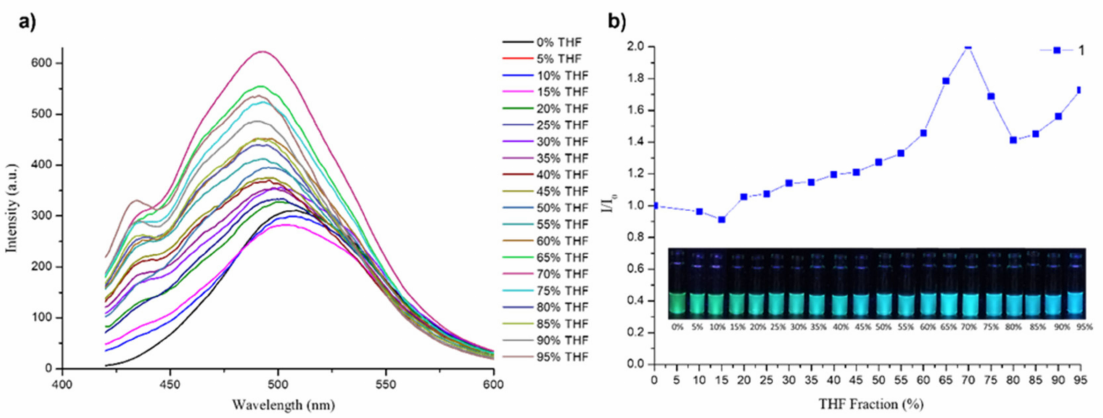
Figure 13. ( a ) Room-temperature emission spectra of 1 in MeOH/THF mixtures of different propor- tions upon excitation at 324 nm. ( b ) Plot showing the increase in the relative emission intensity of 1 in a MeOH-THF solvent mixture with increasing THF fraction. Inset: vials of the various samples under 365 nm UV-lamp